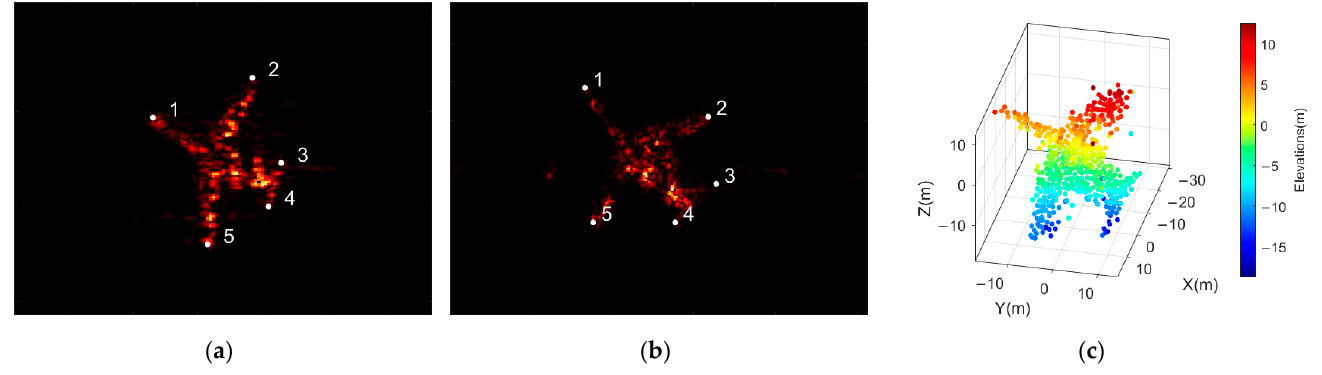
Figure 12. ISAR images and the reconstructed 3D geometry of Yak-42. ( a ) The first frame and ( b ) the fourteenth frame of the ISAR image sequence, and ( c ) the reconstructed 3D geometry of Yak-42.